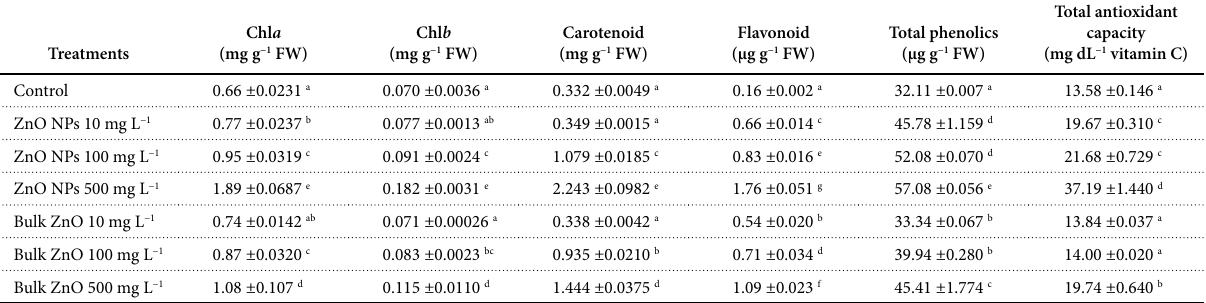
Tab. 2 Effects of ZnO NP and bulk ZnO treatments on the physiological properties of Portulaca oleracea L.